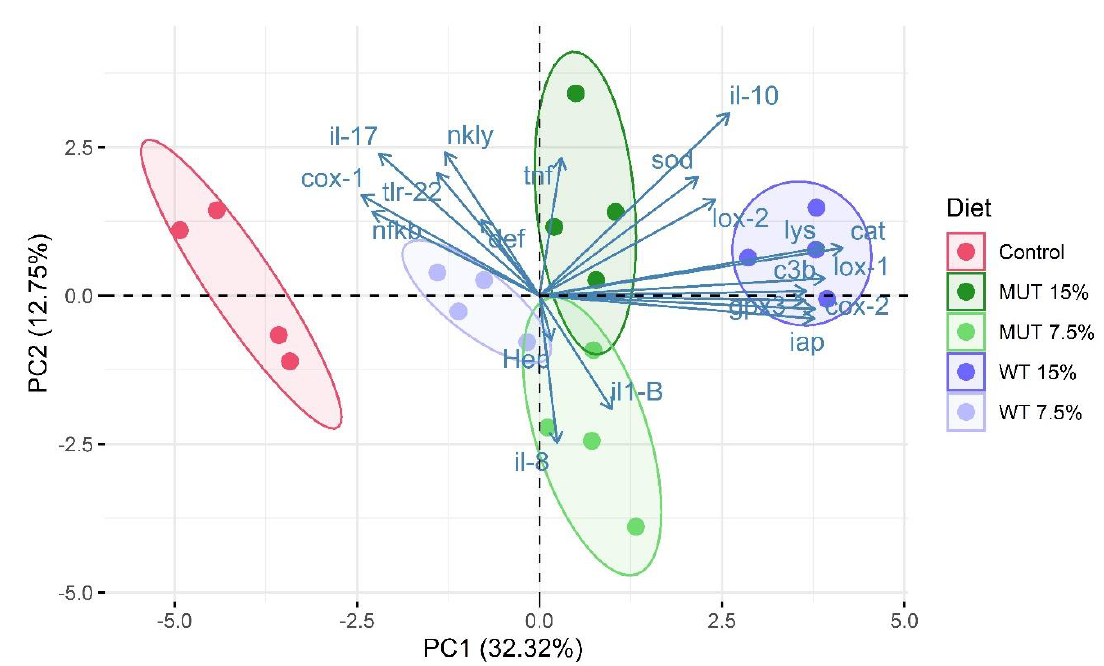
Figure 5. Principal component analysis showing clustering of replicate aquaria (each consisting of a pool of five sampled fish) fed the different diets, on the basis of gene-expression profile. Samples are displayed with respect to the first two components and are colored according to diet. Each colored dot represents an individual biological replicate ( n = 4). The amount of variance explained by each principal component axis is shown in parentheses. Control, nonsupplemented diet; WT, diet supplemented with wild-type Lobosphaera incisa ; MUT, diet supplemented with mutant strain of L. incisa .